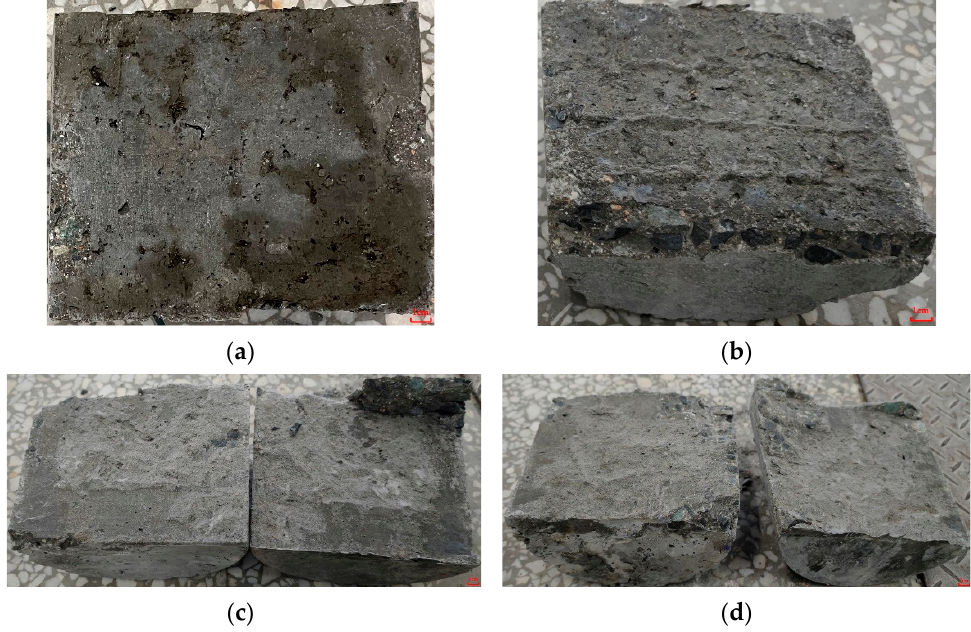
Figure 16. Interface damage status of the split tensile test specimens. ( a ) OC/OC-N; ( b ) OC/OC-Y; ( c ) OC/ECC-N; ( d ) OC/ECC-Y.